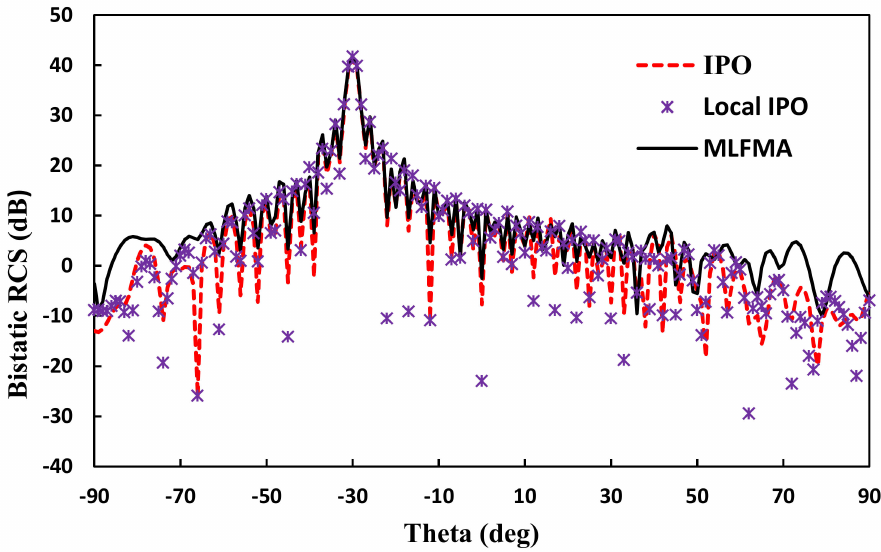
Figure 11. Bistatic RCS results for the composite model with different